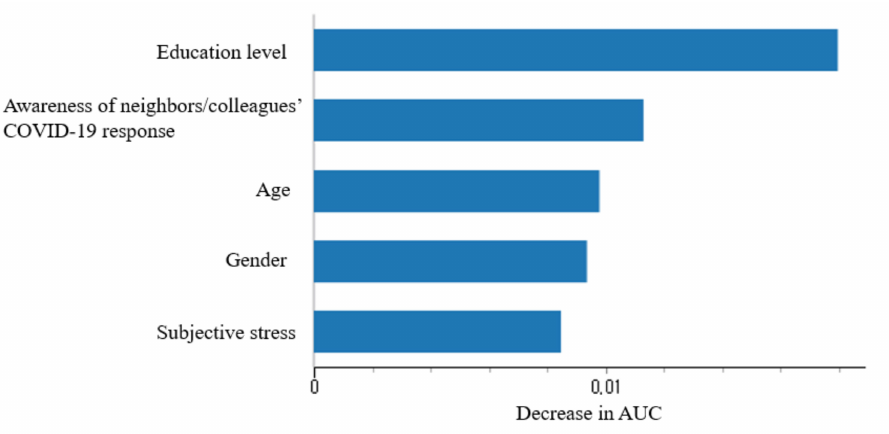
Figure 3. Variable Importance of AdaBoost model for predicting COVID-19-induced anxiety in Korean adults (top 5